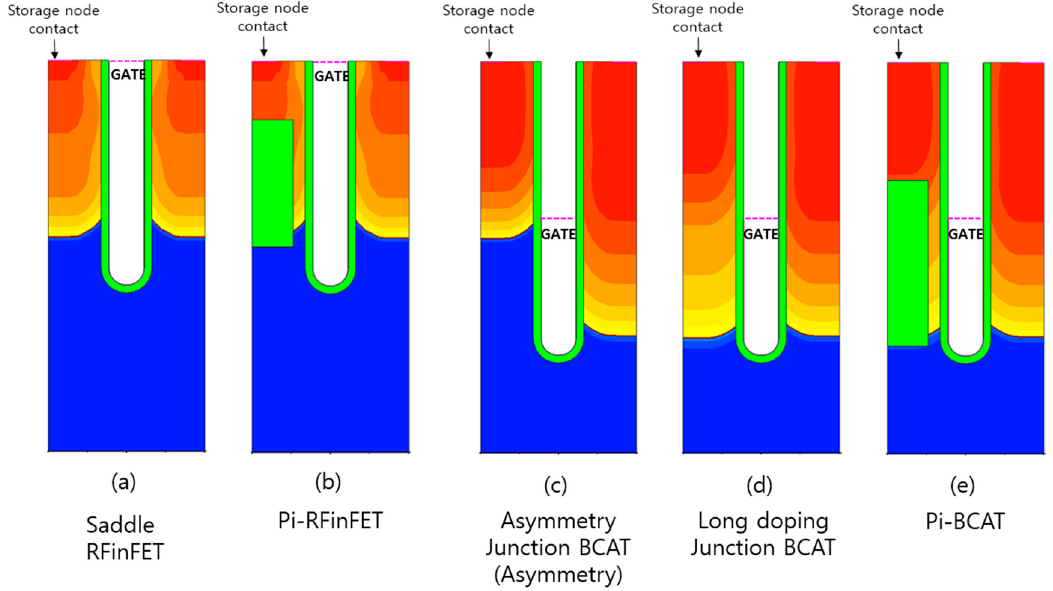
Figure 2. A cross-sectional view of y = 0 x–z in the doping distributions of five structures .